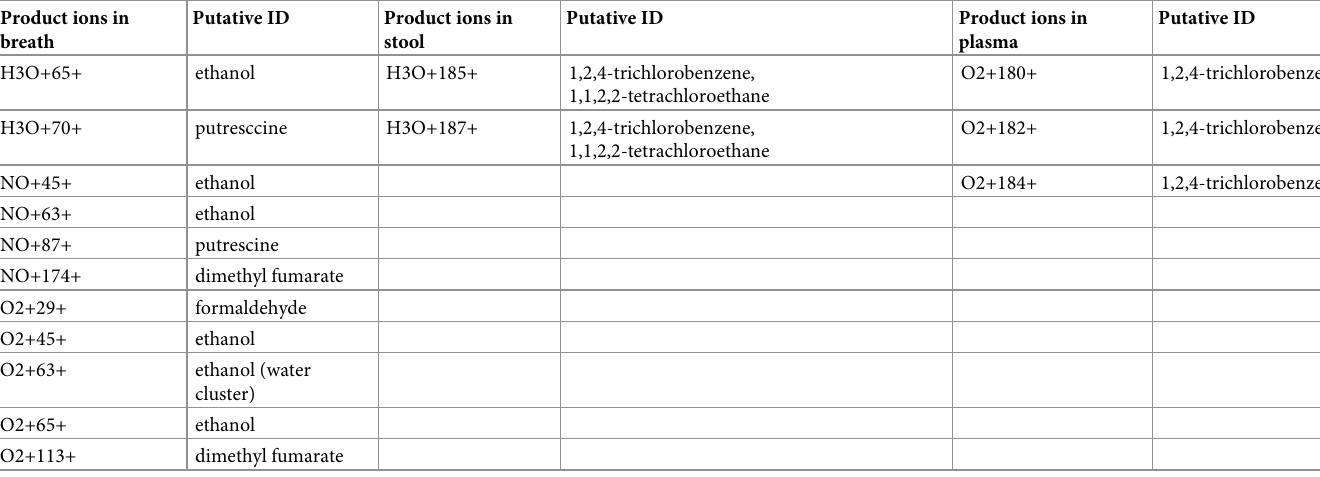
Table 2. Product ions that were significantly different in breath, stool and plasma.